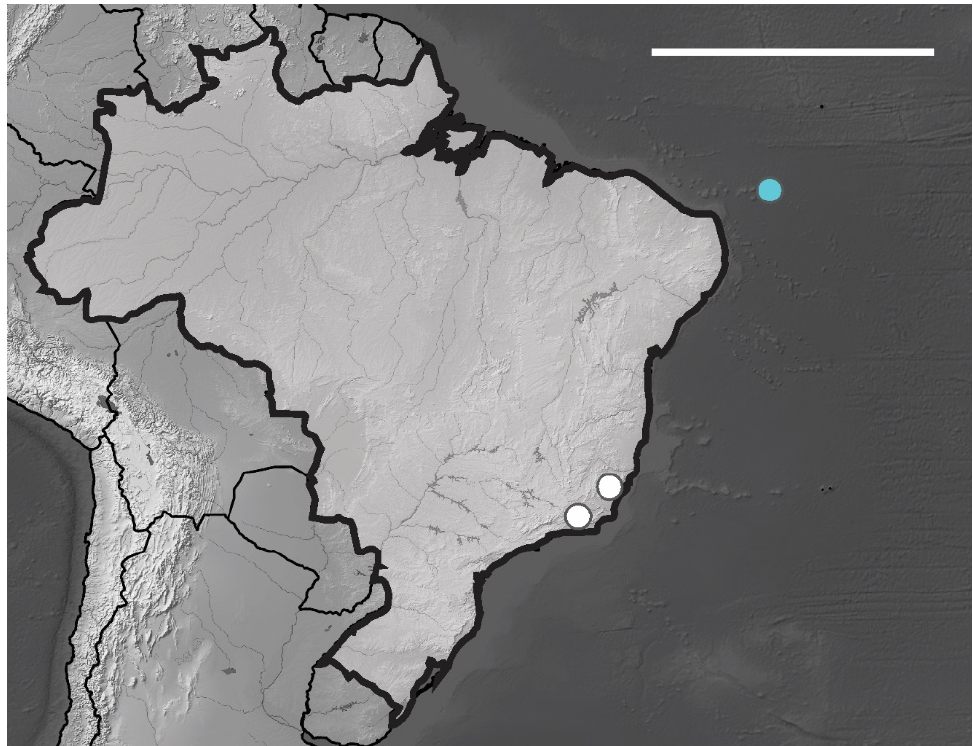
Figure 25. Distribution map for Xenylla yucatana Mills, 1938 records in Brazil. Scale bar: 3000 km.